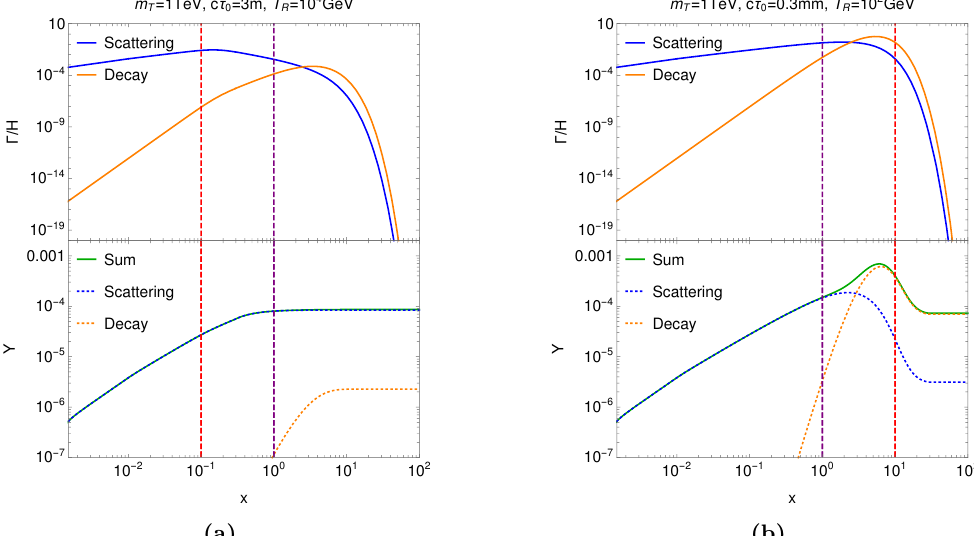
Figure 11. Singlet-triplet model. Above: production rate/Hubble ratio for decay (blue) and scattering (orange). Below: DM yield. We consider T dashed lines denote T = T the observed DM abundance is reproduced for m